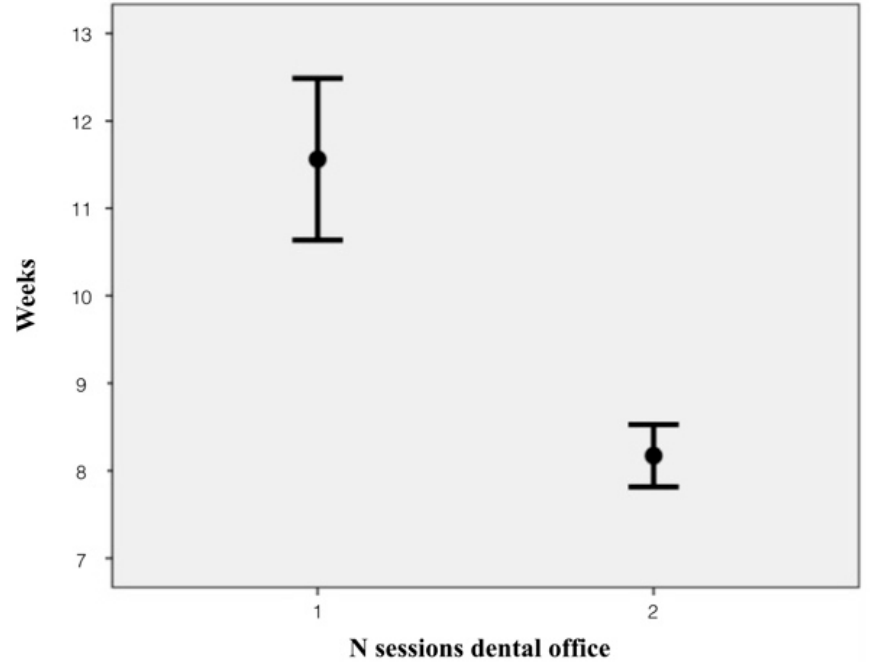
Figure 5. Mean values and confidence intervals for the number of weeks of home whitening until color stabilization was achieved in relation to number of in-office whitening sessions: 1 = Group 1S; 2 = Group 2S.